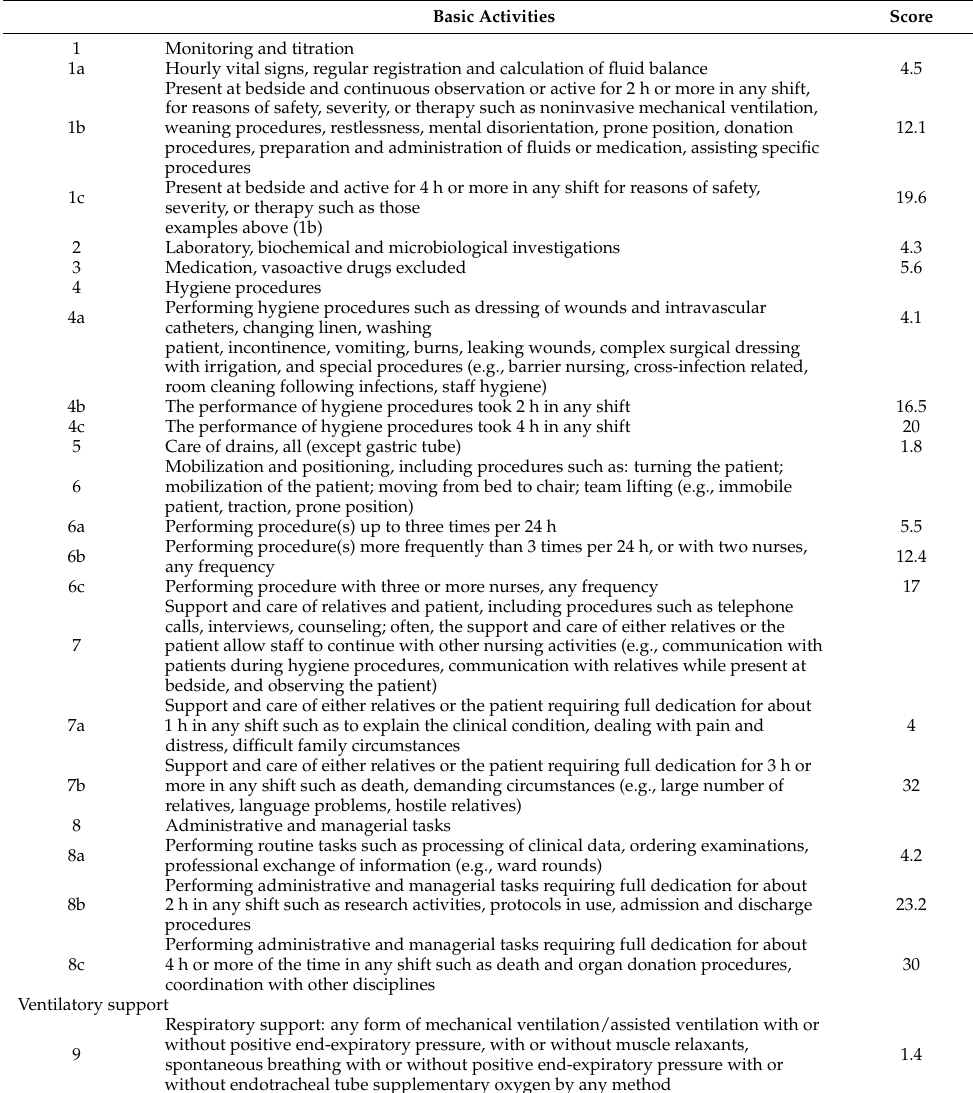
Table A2. Nursing Activities